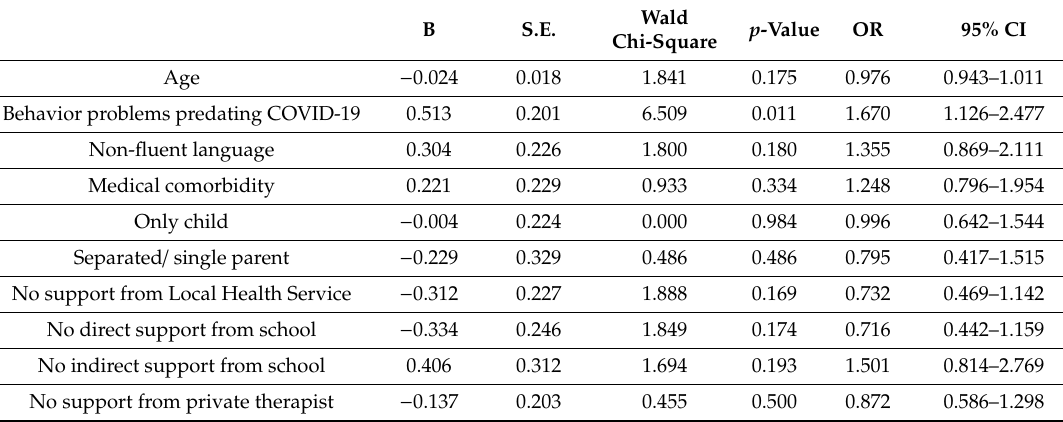
Table 4. Predictors of emergency outbreak negative impact on frequency of behavior problems.